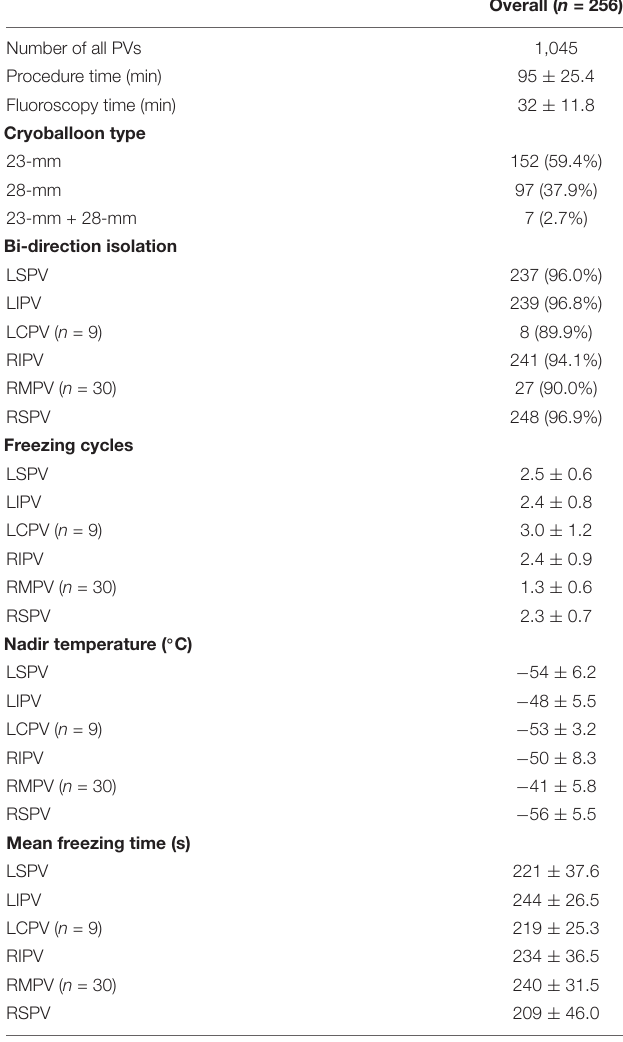
TABLE 2 | Procedural